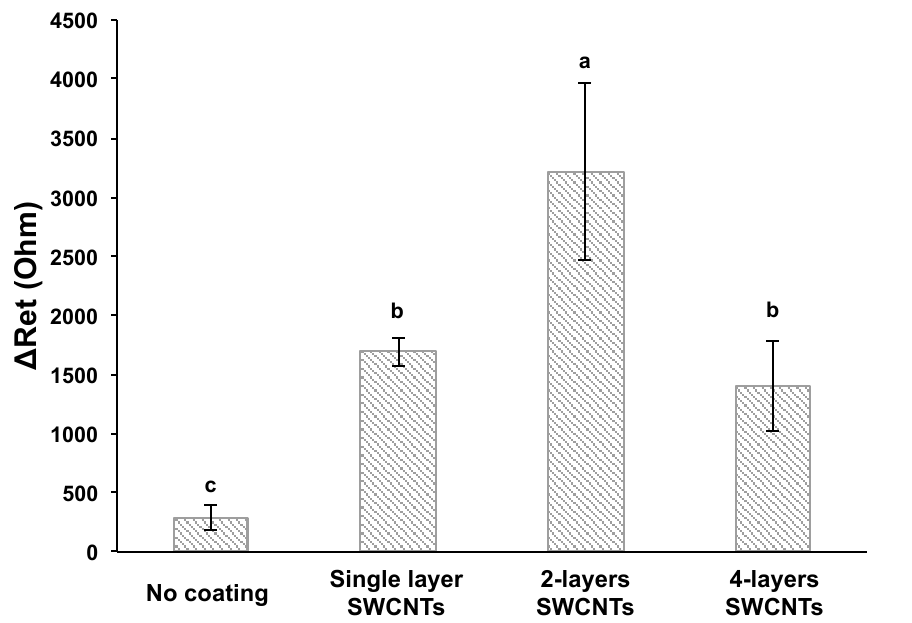
Figure 3. Electrical signal response enhancements by SWCNT coatings. Error bars indicate the standard deviation of the mean. Different letters (a–c) in the figure indicate significant differences ( p ≤ 0.05).